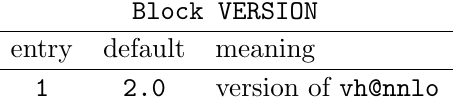
Table 1 . Settings of Block VERSION .